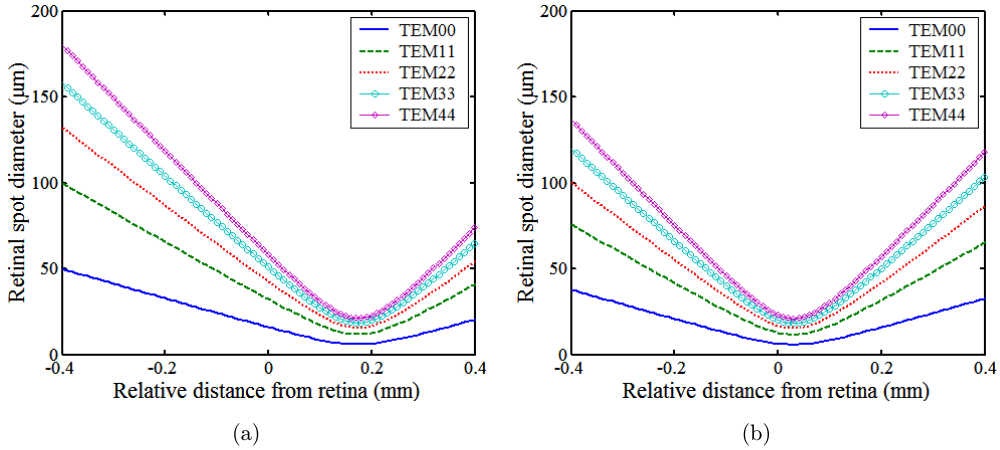
Fig. 5. Calculated beam diameter of di®erent transverse modes focused by human eye under the conditions: wavelength — 532 nm, distance from laser source to the anterior surface of cornea — 2.4m, beam divergence of the embedded TEM 00 mode — 0.2 mrad